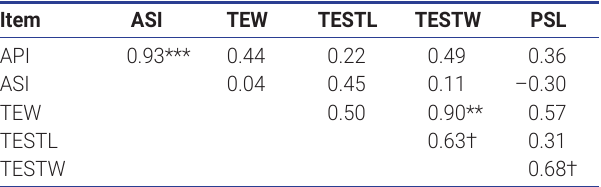
Table 3. Partial correlation coefficients among abdominal profile score and abdominal sagging index and reproduction system in gan-